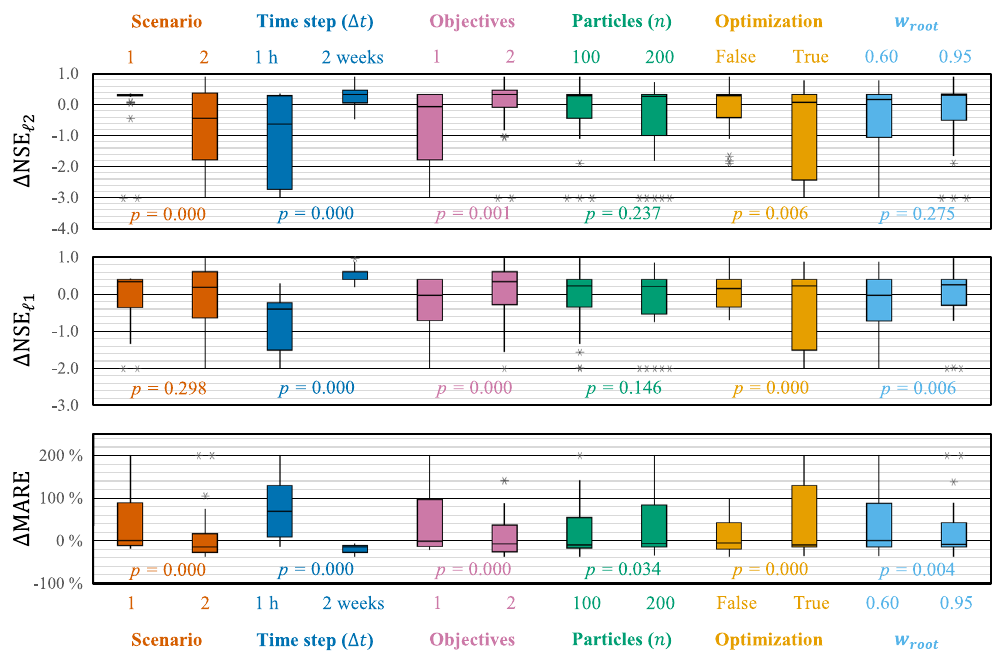
Figure 5. Box plots of the changes in forecasting performance (NSE (cid:96) , NSE (cid:96) , and MARE) achieved while using OPTIMISTS on Experi- 2 1 ment 2 (Indiantown Run). Changes are relative to an open-loop control run where no assimilation was performed. Each column corresponds to the distribution of the error metric changes on the specified scenario or assignment to the indicated parameter. Outliers are noted as stars ≥ − 3, NSE (cid:96) ≥ − 3, and MARE ≤ 200%. Positive values indicate improvements for the NSE (cid:96) and values were constrained to NSE (cid:96) 2 1 the NSE (cid:96) . The meaning for the MARE and for other symbols is the same as those defined in Fig. 1